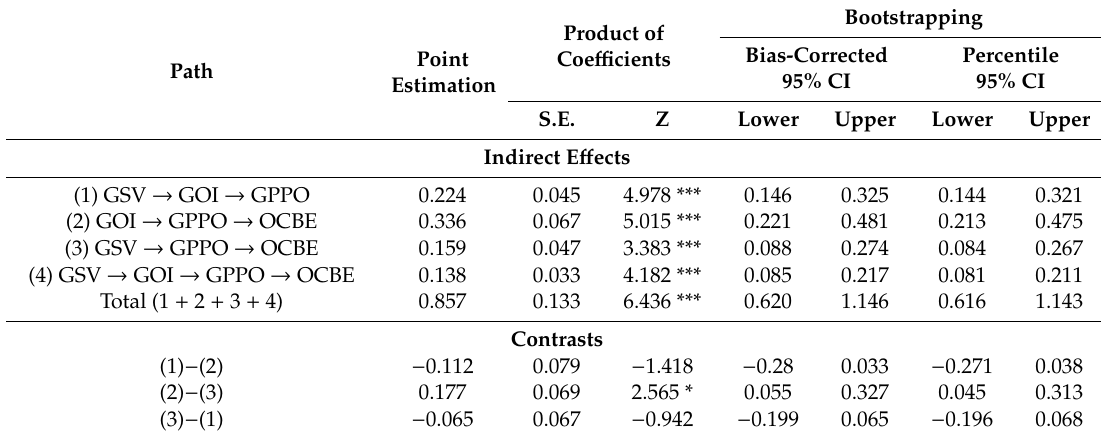
Table 6. Mediation results of GPPO and OCBE when using a confidence interval bootstrap. Product of Point Coe ffi cients Path Estimation